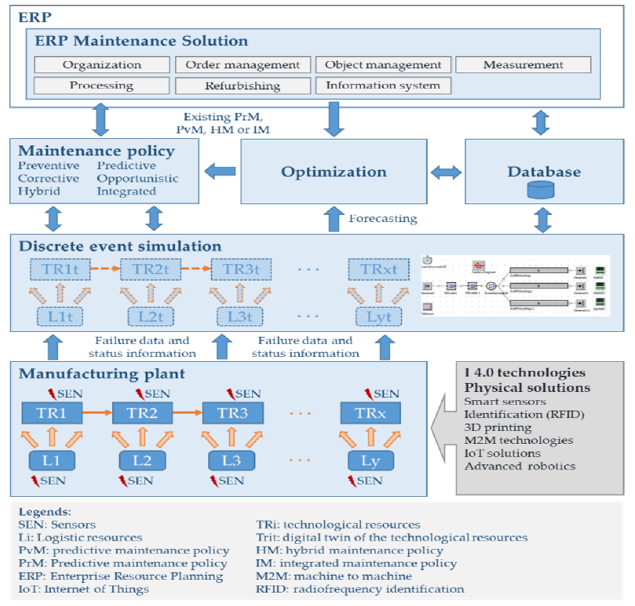
Figure 5. Model framework of digital twin-supported maintenance policy optimization.